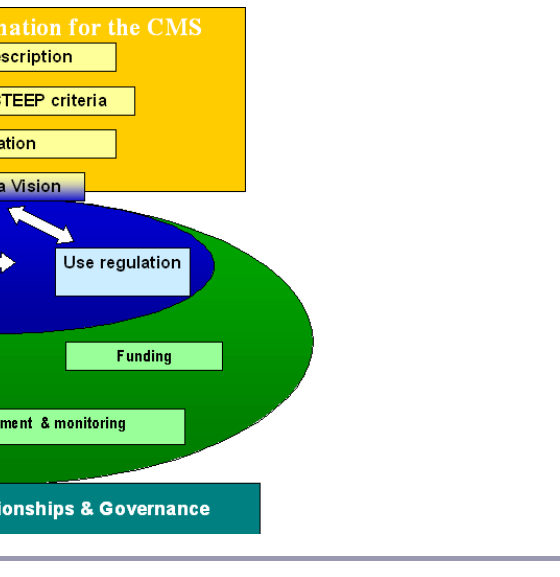
Fig. 1. The framework for Integrated Water Resources Management and hence the Catchment Management Strategy (CMS) in South Africa (DWAF 2007, adapted from DWAF 1999). Clusters of contextual information and substrategies for the CMS fall into four parts (color